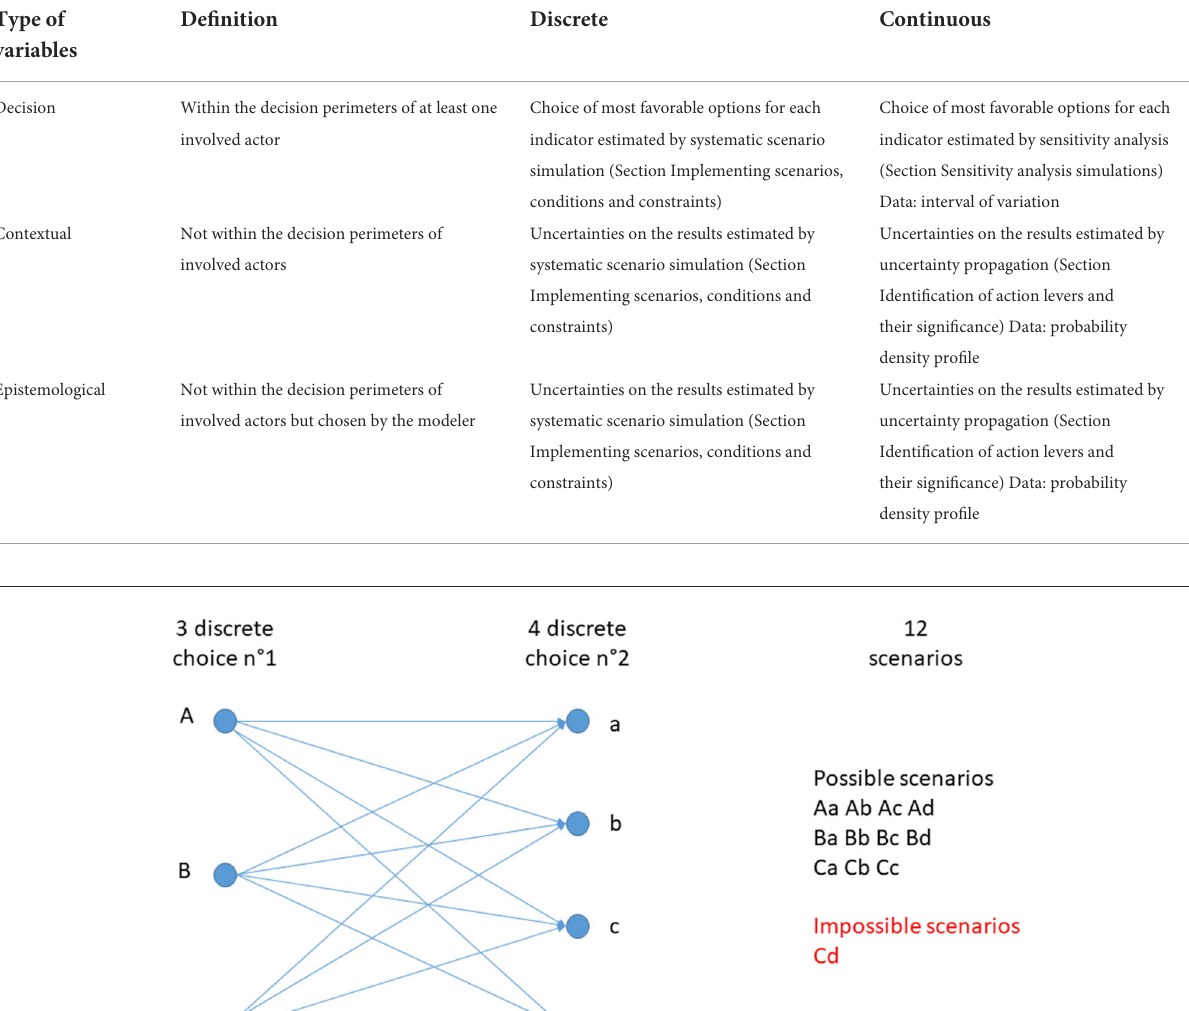
TABLE 3 Type of simulation according to types of variables.